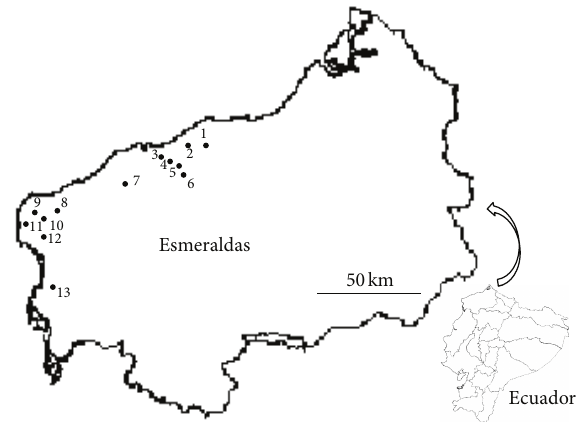
Figure 1: Area of study and sample points. 1: R´ıo Verde (RV), 2: Estero Camarones (Ca), 3: Estero Tachina I (T-I), 4: Estero